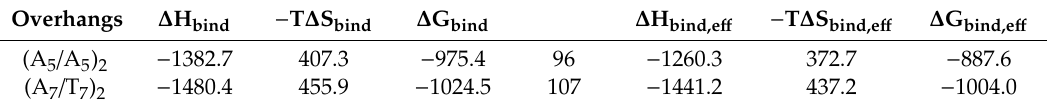
Table A2. Total and e ff ective enthalpy ( ∆ H bind , ∆ H bind,e ff ), entropy ( − T ∆ S bind , − T ∆ S bind,e ff ), and free energy of binding ( ∆ G bind = ∆ H bind − T ∆ S bind , ∆ G bind,e ff = ∆ H bind,e ff − T ∆ S bind,e ff ) for the two dimeric ssiRNAs with G 5 TEA-core PAMAM dendrimers. All values are in kcal / mol (standard deviation for all data in Table A2 is less that 3%). N e ff is the number of positive dendrimer charges e ff ectively involve in ssiRNA binding. Adapted from [57] with permission of the American Society of Chemistry.